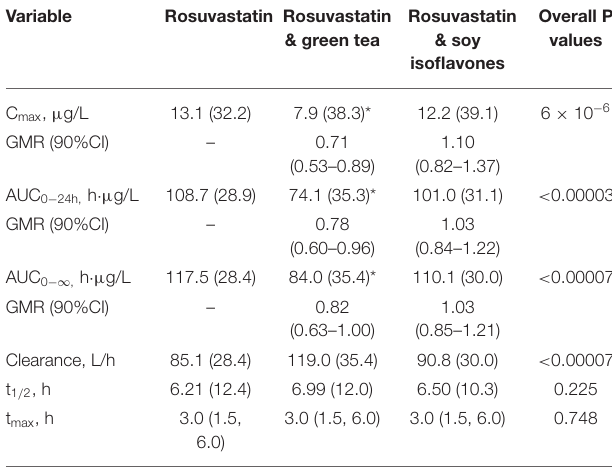
TABLE 2 | Effect of green tea extract and soy isoflavones on the pharmacokinetic parameters of rosuvastatin in 20 healthy subjects.